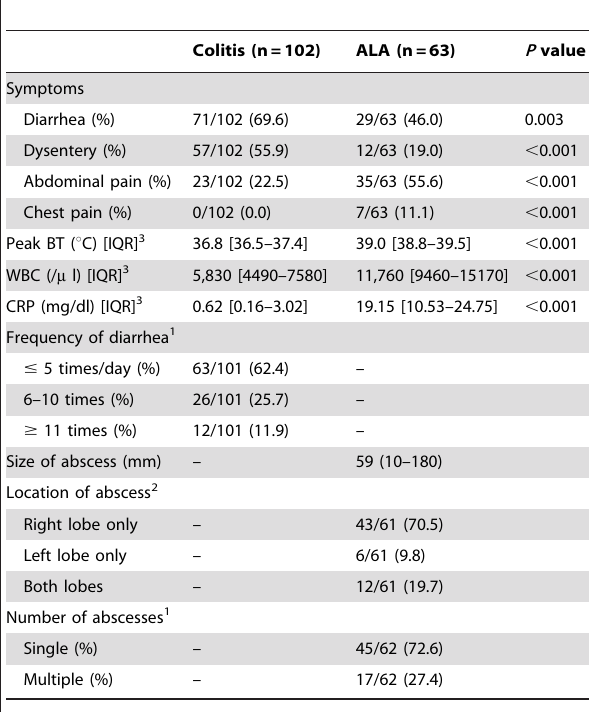
Table 2. Clinical features of amoebic colitis and